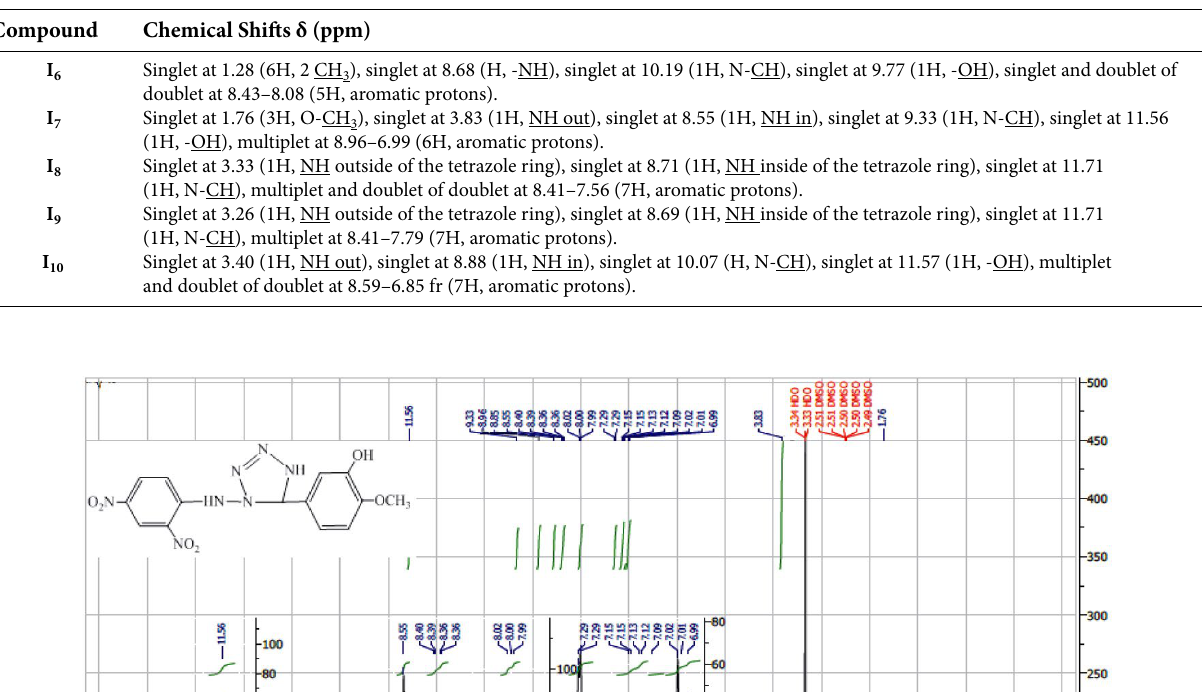
Table 5. The 1 H NMR spectral data of tetrazole derivatives I 6 – I 10 (in DMSO- d 6 ).